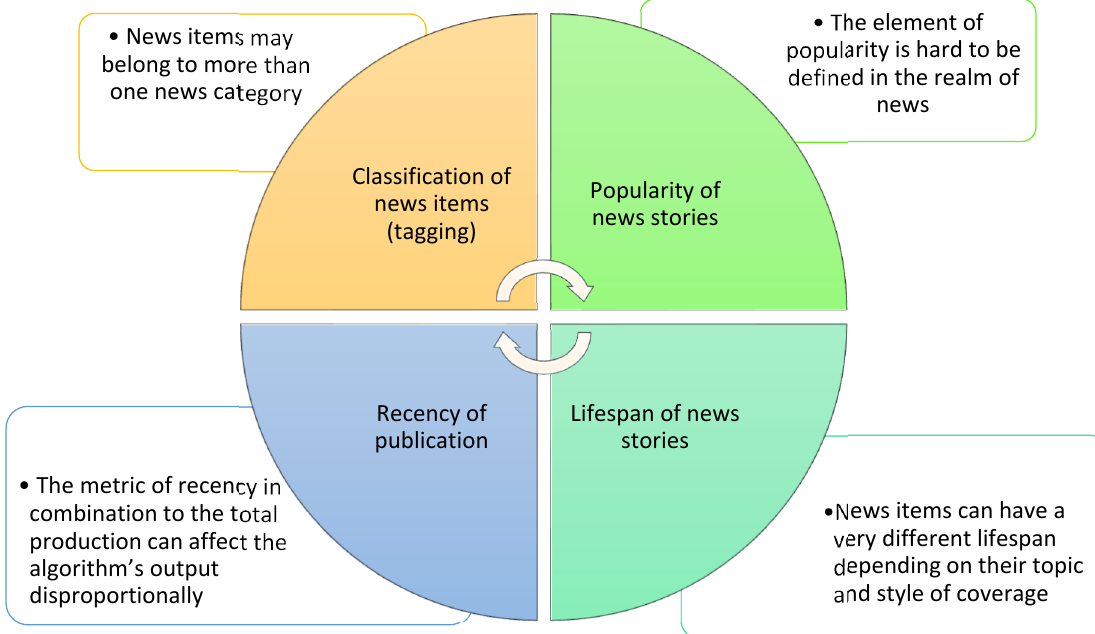
Figure 2. Design challenges for NRS related to the nature of news.